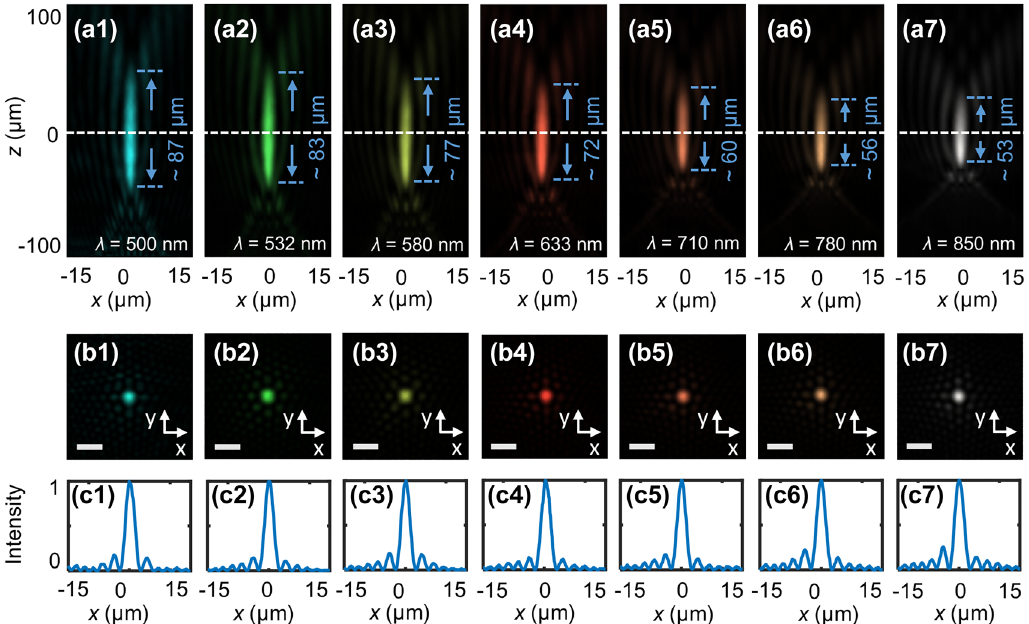
Figure 6: Measured intensity distributions of the PB in the needle-like region. (a1) – (a7) Intensity distributions of the PBs ( m = 4) along the optical axis ( x – z plane) and (b1) – (b7) measured transverse fi eld distributions ( x – y plane) at the focal plane of the PBs at wavelengths λ = 500, 532,580,633,710,780,and850nm.Tofacilitatevisualization,theintensitydistributionsin(a1) – (a7)arefalse-coloredimages,becausethese intensity distributions are extracted from the reconstructed three-dimensional image, while the intensity distributions in (b1) – (b7) are true- colored images. (c1) – (c7) Normalized intensity pro fi les along the horizontal axes at the center of the focal spots. Scale bar = 6 μ